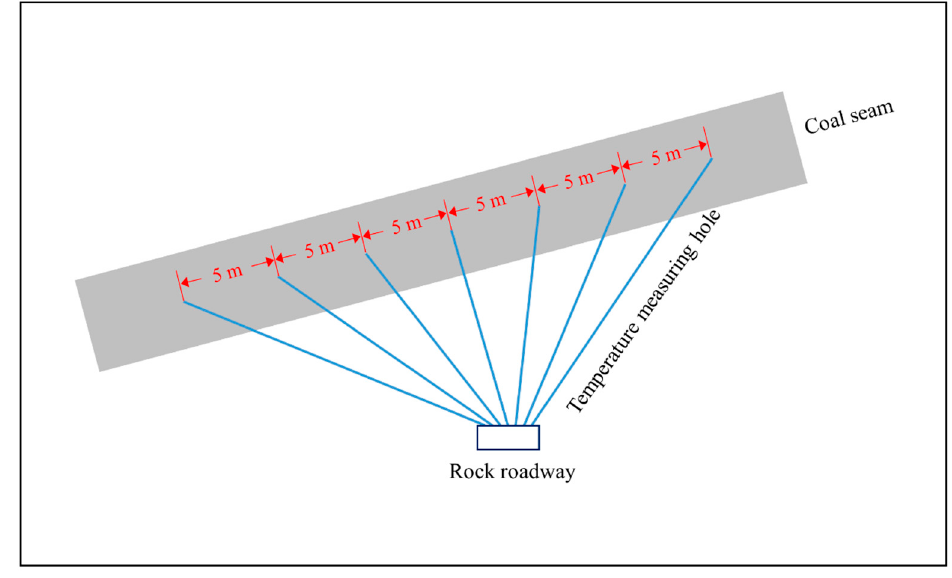
Figure 11. Schematic diagram of outburst prediction based on coal temperature monitoring.